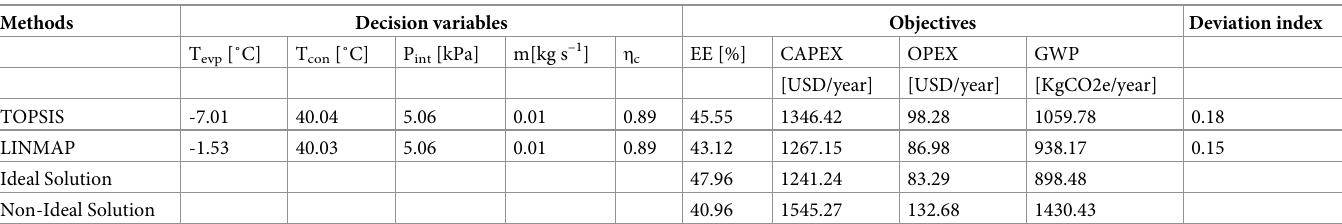
Table 8. Fourth objective optimization of the considered case.